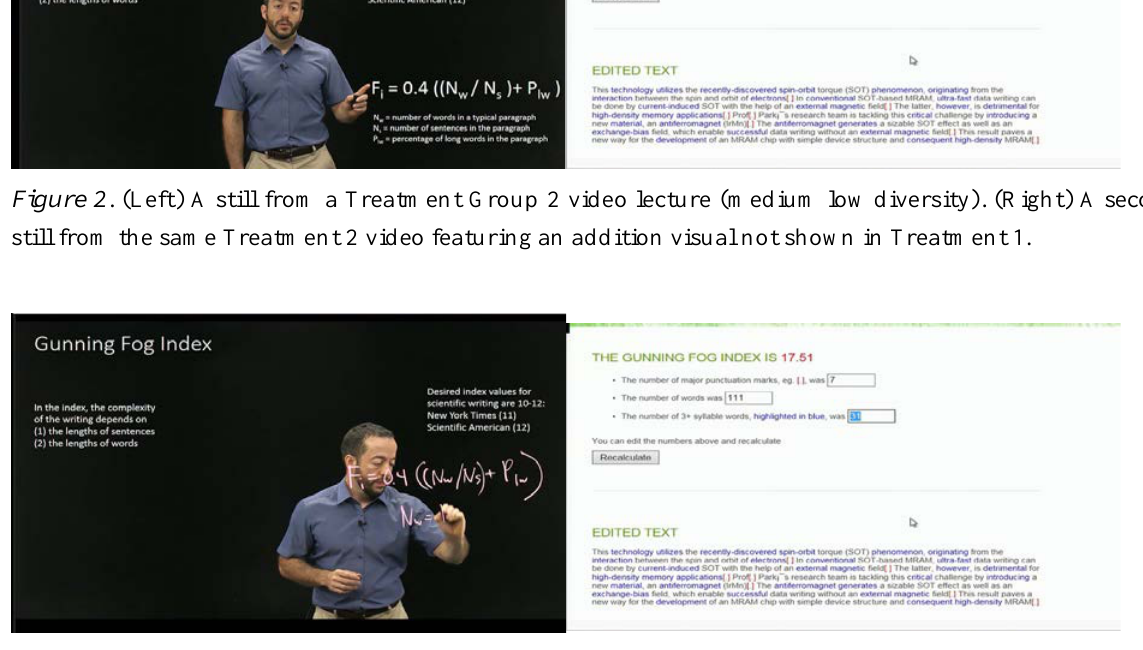
Figure 3. (Left) A still from the Treatment Group 3 video lecture (medium high diversity) that features the same text on the slide background as in the Treatment 1 and 2 versions along with Khan-style writing by the instructor. (Right) The Treatment Group 3 version of the video lecture includes the same visual shown in the Treatment 2